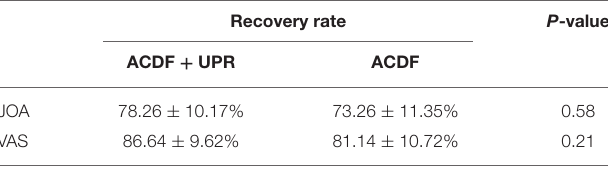
ACDF, anterior cervical discectomy and fusion; UPR, uncinate process resection; JOA, Japanese orthopedic association; VAS, visual analog scale. P < 0.05 is considered as significant.